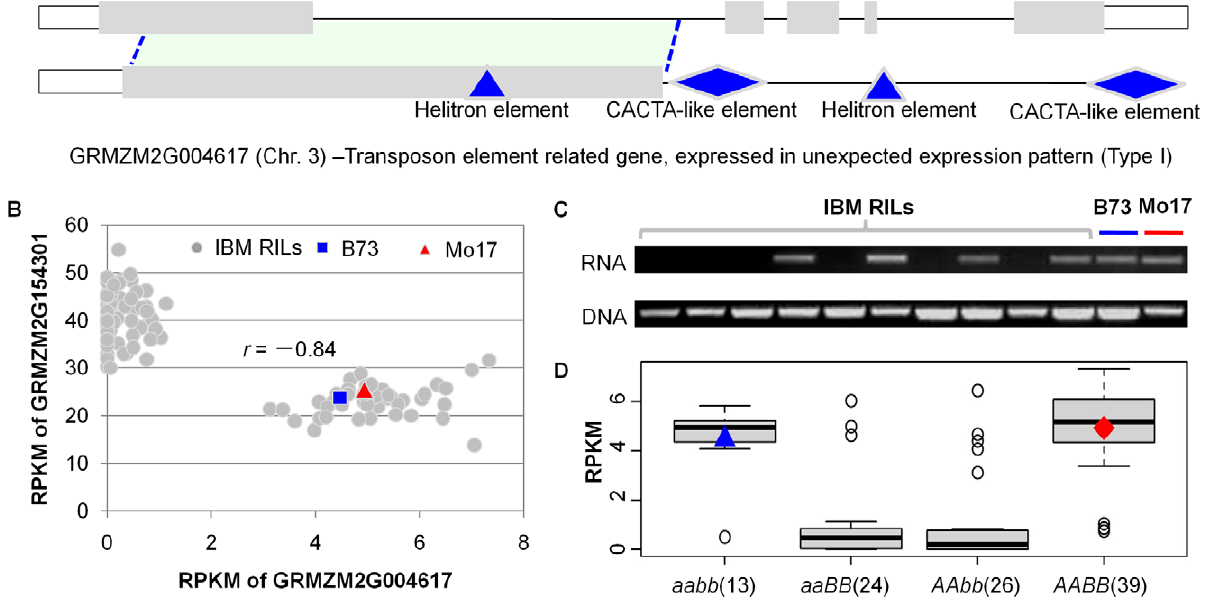
Figure 7. Co-expression complementary effect between a transposon-related gene and its ancestral syntenic gene. (A) The homologous relationship between the transposon-related gene ( GRMZM2G004617 ) and its ancestral syntenic gene GRMZM2G154301 . The blue dotted lines and the light blue area show the homologous region between the two genes. The grey boxes represent the coding regions, while the open boxes indicate the untranslated regions. The transposon annotation was done using CENSOR (http://www.girinst.org/censor/index.php). The blue triangle and diamond represent helitron element and CACTA-like element, respectively. (B) The negative co-expression correlation between the two genes. (C) The validation of RT-PCR and genomic DNA PCR of the transposon-related gene ( GRMZM2G004617 ), which exhibits unexpected expression patterns in the RILs. (D) Two-marker interaction (M3735 located in chromosome 4 is designated as locus A and M5604 in chromosome 7 is denoted as locus B , neither of which are linked to the differentially expressed genes) was significantly associated with the transcriptomic variation of type I gene GRMZM2G004617 in the RILs ( P =1.3E-07). aabb shows the genotype of B73, while AABB represents Mo17 genotype. The numbers close to the genotype show the number of RILs with the same genotype. The y-axis shows the normalized expression levels (RPKM). The blue triangle indicates the expression level in B73, while the red diamond indicates the expression level in Mo17.